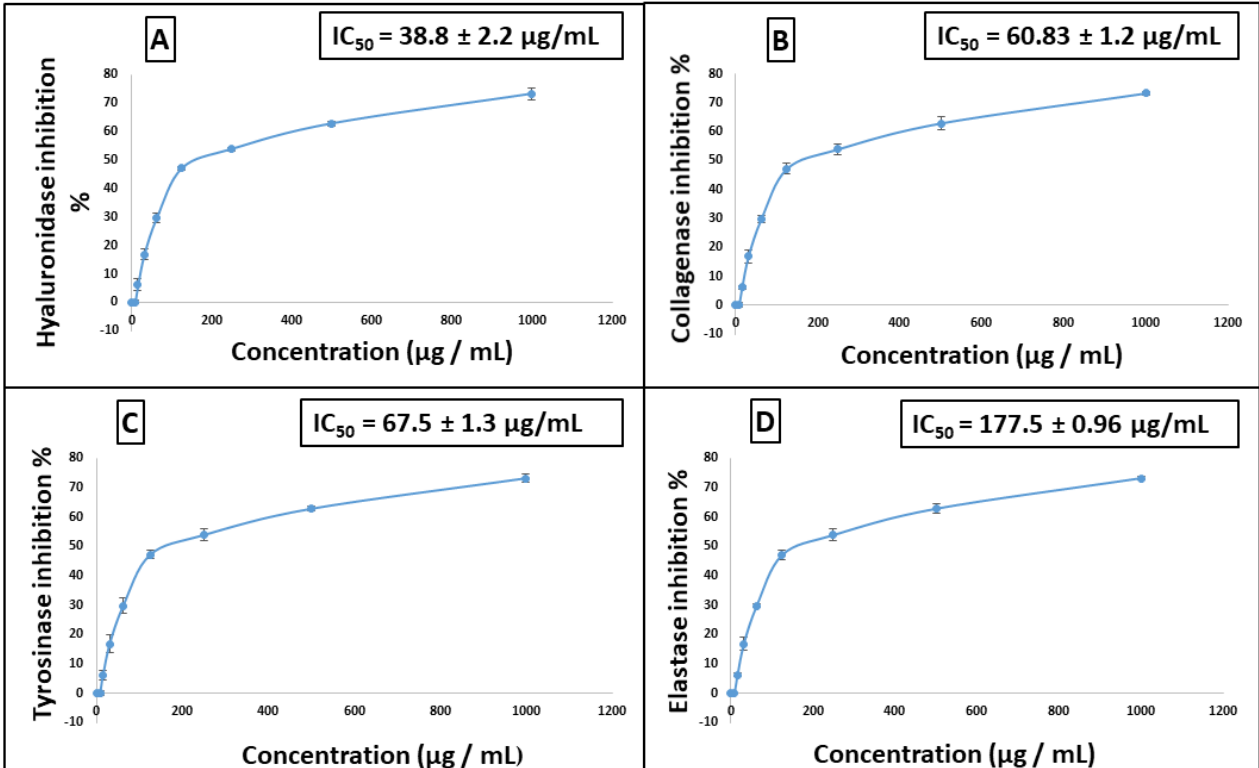
Figure 3. ( A ) Dose–response curve of SSHF inhibition of hyaluronidase, ( B ) collagenase, ( C ) tyrosinase, ( D ) elastase activity. All determinations were carried out in triplicate, and the values are expressed as mean ± SD.